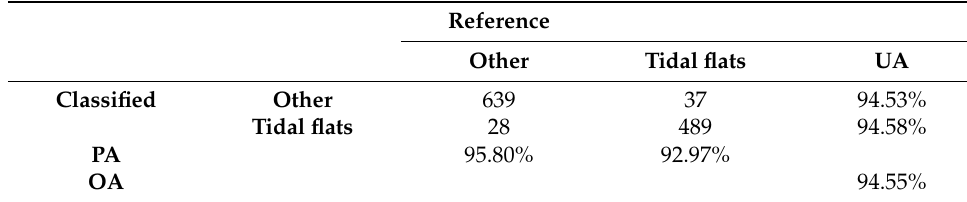
Table 1. Confusion matrix of the proposed tidal flat